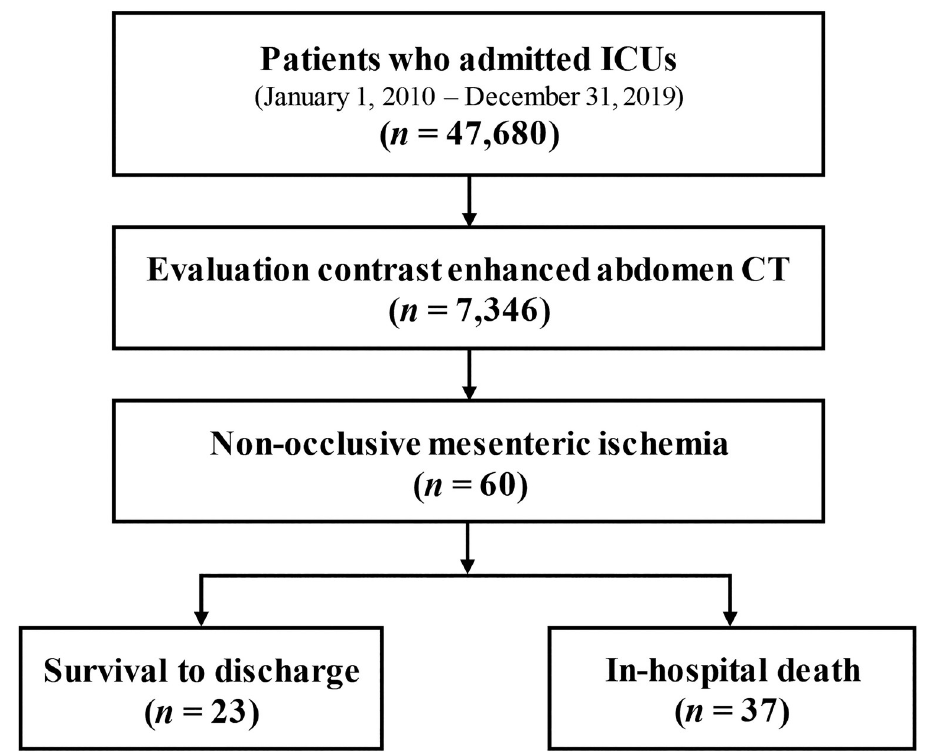
Fig 1. The patient enrollment scheme for this study. CT, computed tomography; ICU, intensive care